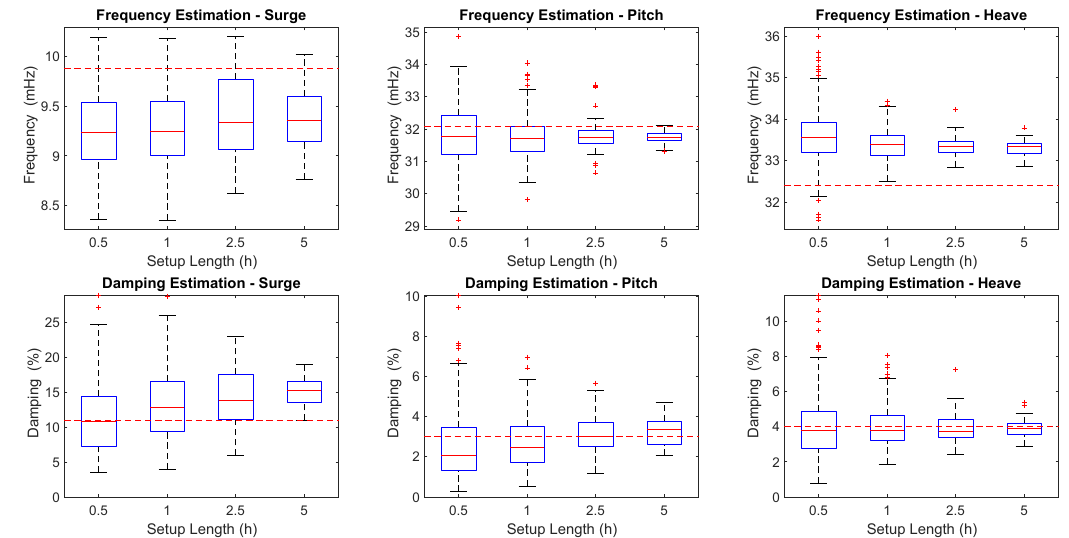
Figure 11. Boxplot representation of surge, pitch, and heave modal properties, where the red dots represent outliers’ values, and the theoretical values from Table 4 are represented by a red dashed